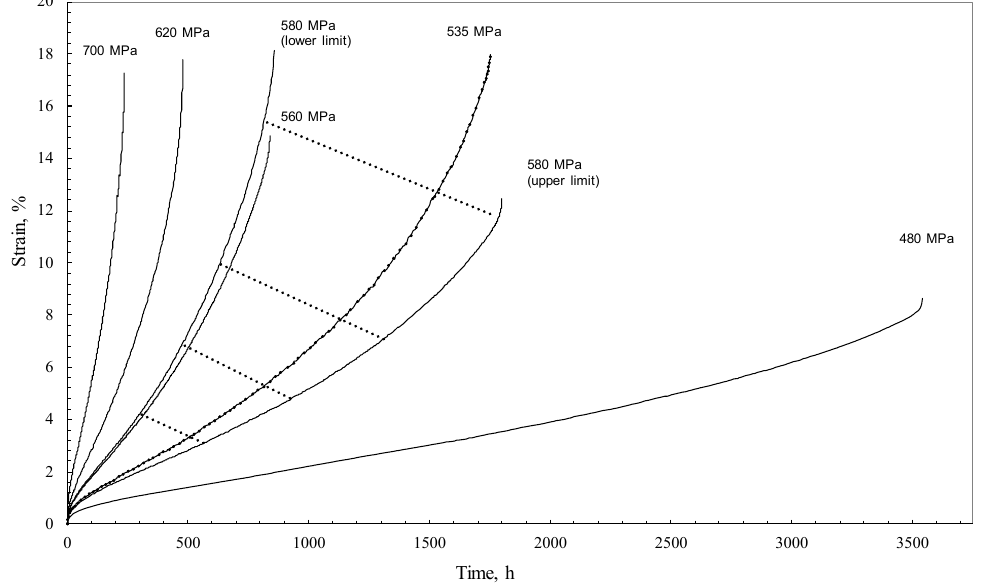
Figure 1. Uniaxial creep curves at 773 K for Ti-6.2.4.6 (including the band of creep curves obtained at a repeat stress of 580 MPa bounded by the maximum and minimum rupture times).